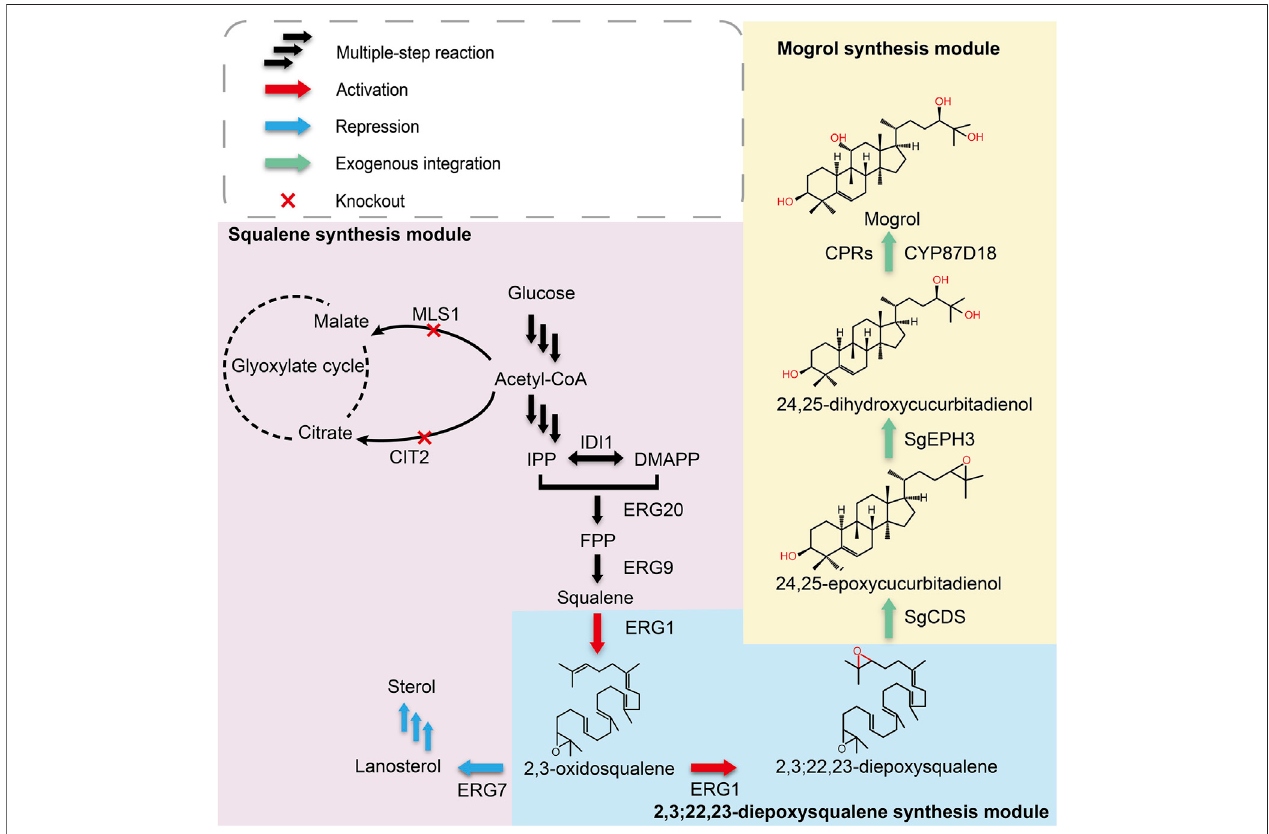
FIGURE 1 | Biosynthetic pathway for mogrol production in S. cerevisiae. Single arrows represent one-step conversions, whereas triple arrows represent multiple steps. Overexpressed steps are shown as red arrows, suppressed steps are shown as blue arrows, and exogenous integrated steps are shown as green arrows.Abbreviations:IPP,isopentenylpyrophosphate;DMAPP,dimethylallylpyrophosphate;FPP,farnesyl;IDI1,isopentenyldiphosphateisomerase;ERG20,farnesyl pyrophosphate synthetase; ERG9, squalene synthase; ERG1, squalene epoxidase; ERG7, lanosterol synthase; MLS1, malate synthase; CIT2, citrate synthase; SgCDS, cucurbitadienol synthase; SgEPH3, epoxide hydrolase; CYP87D18, cytochrome P450